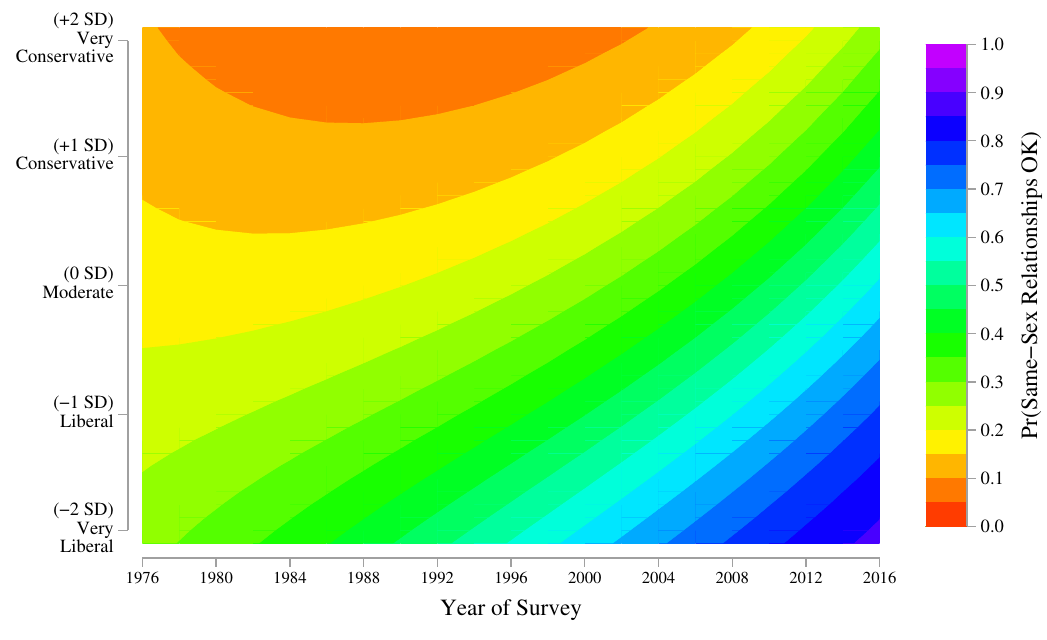
Figure 18: Contour plot of predicted probabilities of viewing same-sex relationships as acceptable at the intersections of political views and survey